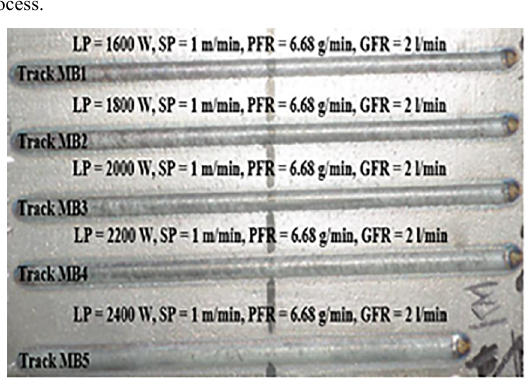
C deposits with 4